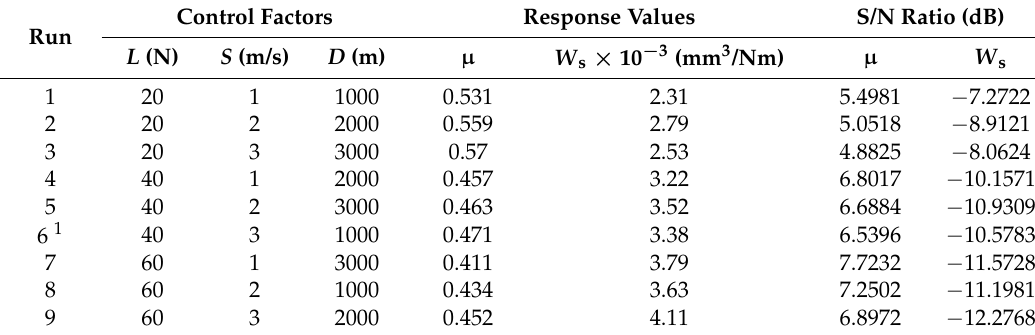
Table 3. Taguchi L 9 OA and multi-response results with signal to noise (S/N) Ratio.